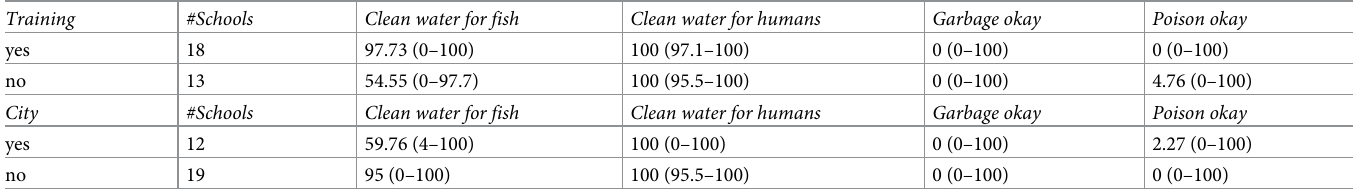
Classrooms classified by training status and